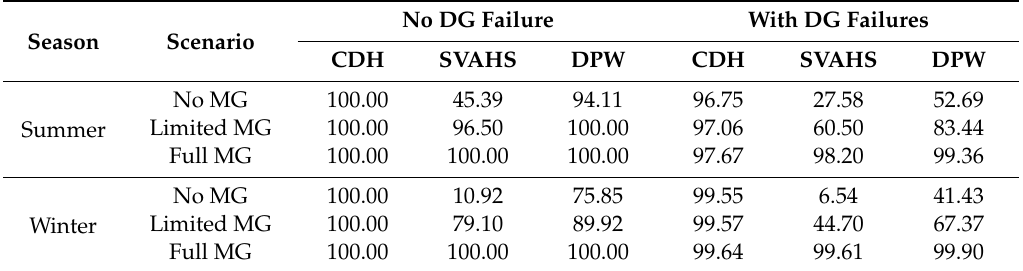
Table 7. Mean survival rates of the system with CDH PV in 3 days outages.